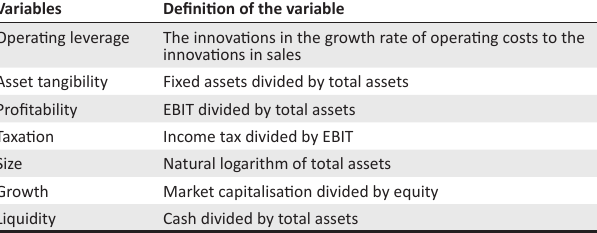
TABLE 3: Definition of independent